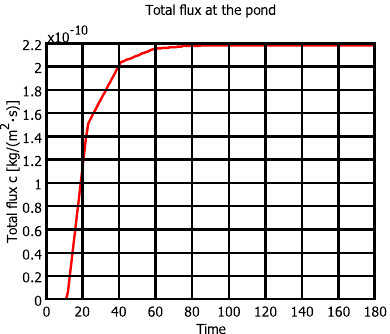
Figure 5. Total flux’s pollute distribution at the pond.